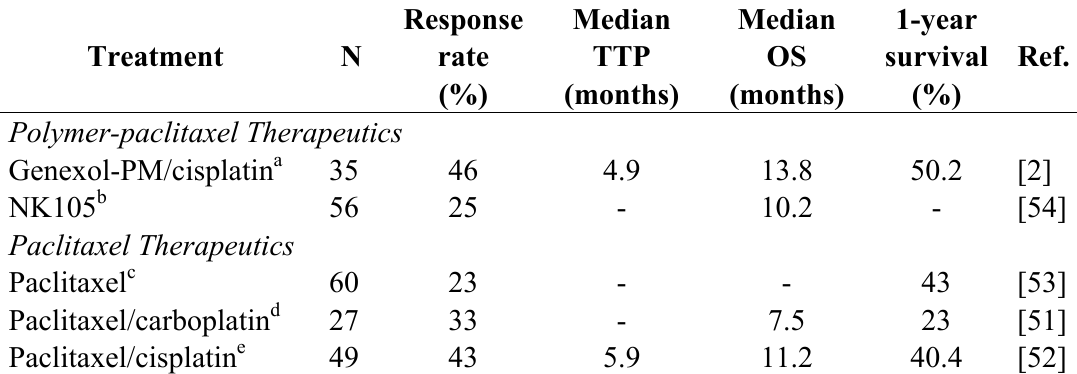
Table 13. Clinical outcomes of polymer paclitaxel and paclitaxel therapy in patients with advanced gastric